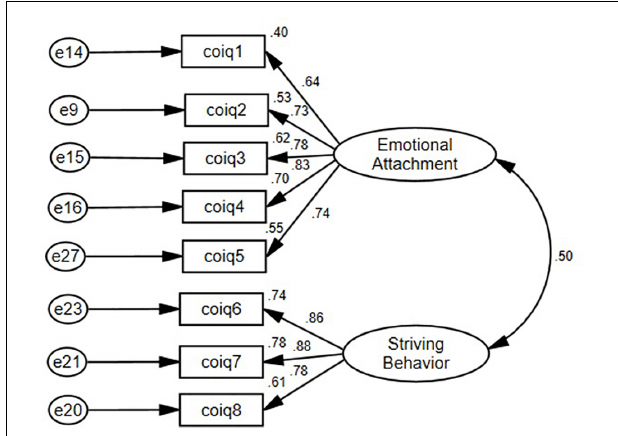
FIGURE 2 | Model specification of the cross-validated, 8-item, bi-dimensional Chinese Organizational Identification Questionnaire (Study 2).